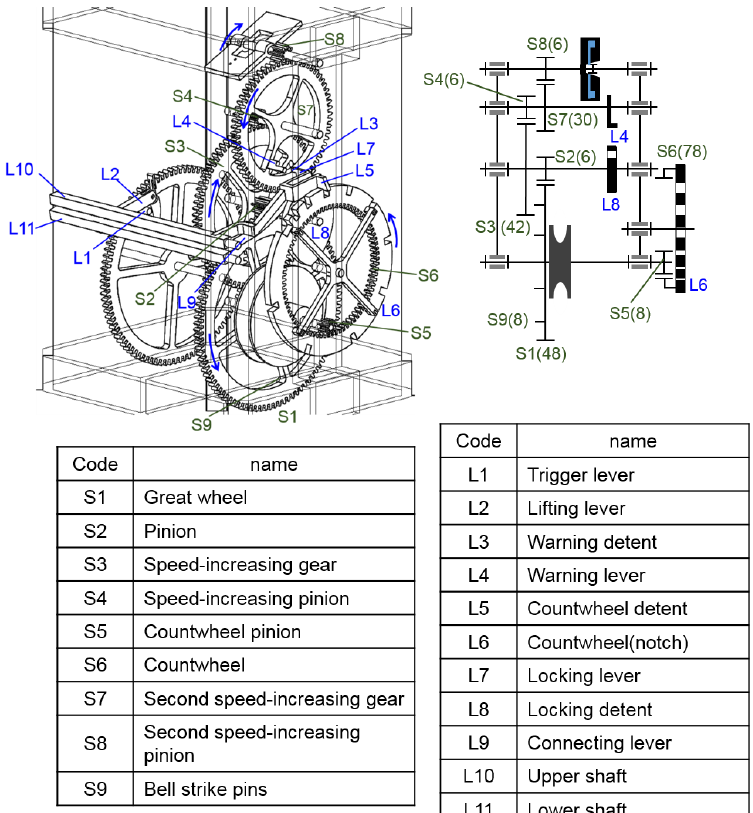
Figure 4. Striking train of the Liechti iron chamber clock